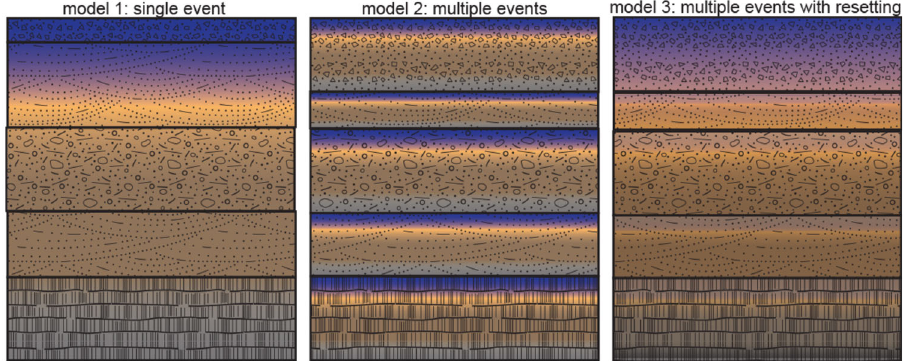
Fig. 4 Hypotheses for the pattern within weathering pro fi les for Al/Si materials and Fe/Mg clays. A scenario of a single climate transition (left) and another case of multiple repeated climate transitions spread out over geologic time (center panel). A third hypothesis is that multiple events occur, but the latest event chemically overwrites older weathering pro fi les as Fe migrates downward in the section. The blue tone unit refers to Al/Si (Fe-poor) materials, and the warm brown color indicates the occurrence of Fe/Mg smectites. Welles crater (~0.2 °S, 45.9 °W) in Xanthe Terra. This crater, Dating the cap units associated with computational stratigra- which is breached by a series of fi ssures and graben to the phy through the southern highlands reveals a wide range of southwest and by the Shalbatana out fl ow channel to the model ages, but most are ~3.8 – 3.6 Ga, which is consistent with northeast, has a modeled age of ~3.57 Ga based on the analysis previous results 14 . The youngest example corresponds to weath- ering pro fi les found on the fl oor of the125 km diameter Orson of 76 craters superimposed on the rim and ejecta materials. A